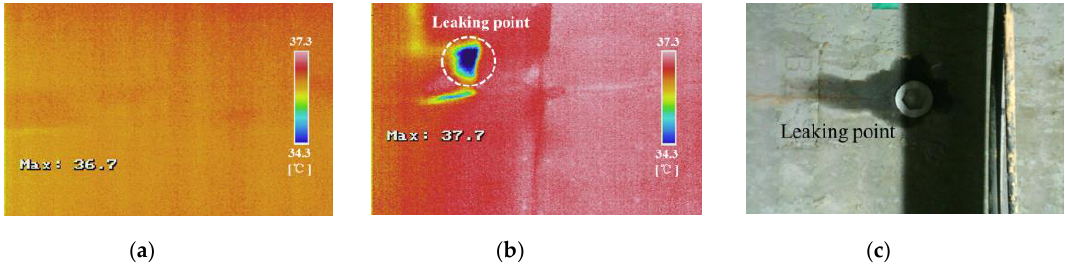
Figure 10. The field detection results of the thermal infrared camera: ( a ) safety conditions; ( b ) leakage conditions; ( c ) leakage of a grouting hole in the field.